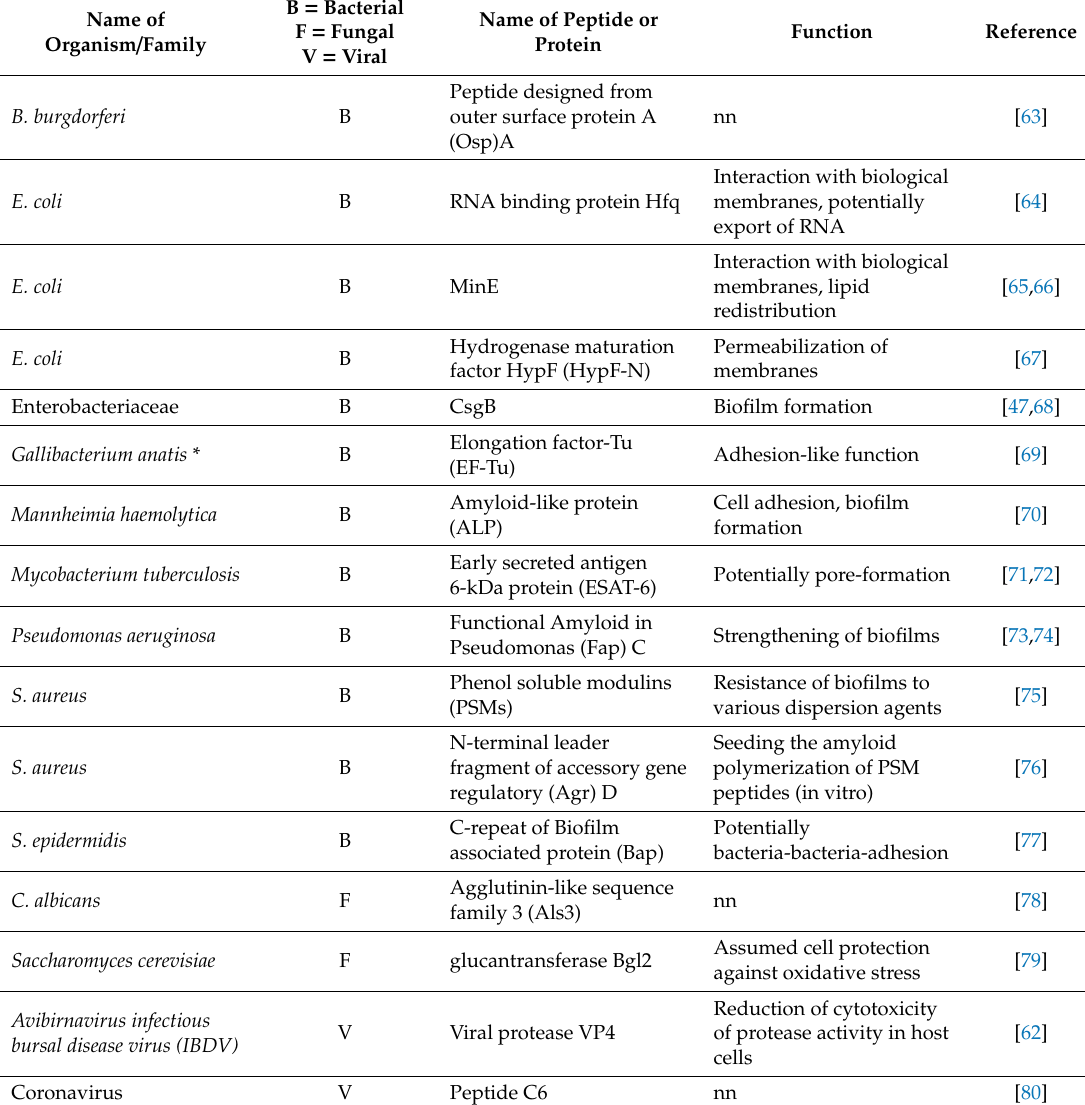
Table 2. Amyloidogenic proteins and peptides from microbial organisms. The indicated organism or family must not be imperatively the only organism producing the respective peptide or protein but was used in the underlying investigation. (nn: not known so